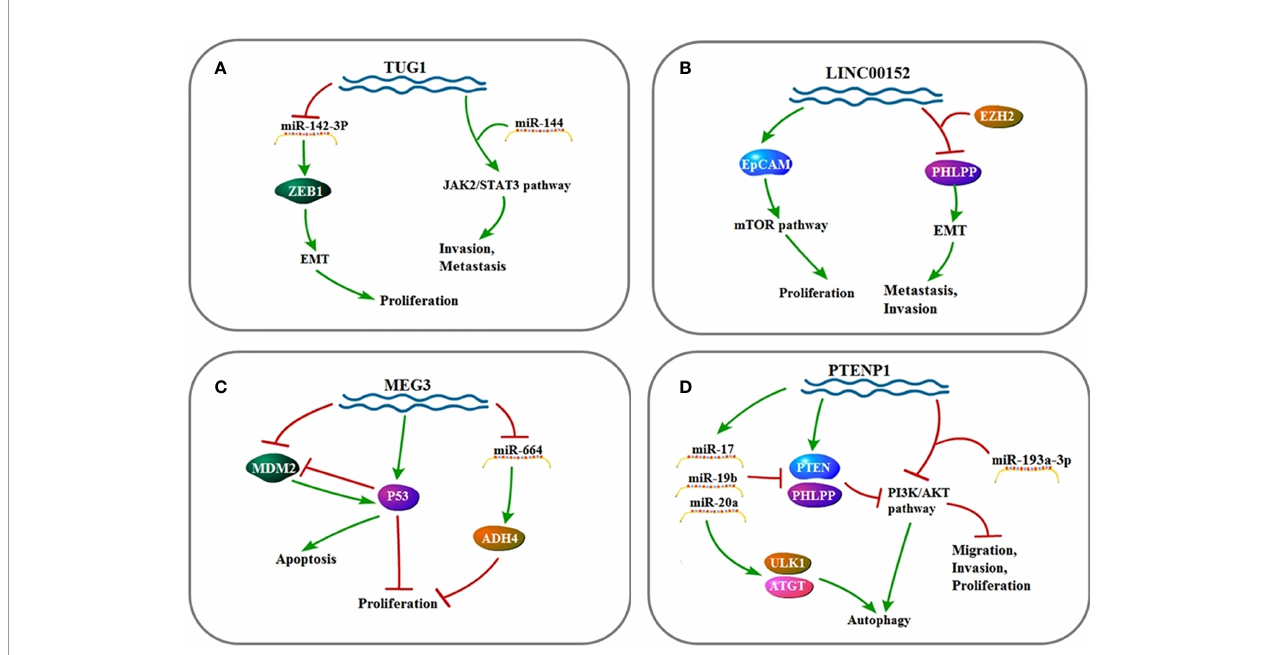
FIGURE 4 | (A) Signaling pathway of TUG1 : TUG1 affects cell invasion, metastasis, and proliferation by up-regulating EMT and JAK2/STAT3 pathway. (B) Signaling pathway of LINC00152 : LINC00152 affects cell invasion, metastasis, and proliferation by up-regulating EMT and mTOR pathway. (C) Signaling pathway of MEG3 : MEG3 affects cell proliferation and apoptosis by up-regulating P53 and ADH4. (D) Signaling pathway of PTENP1 : PTENP1 affects cell invasion, proliferation, migration, and autophagy by up-regulating miR-17, miR-19b, and miR-20a as well as down-regulating the PI3K/AKT